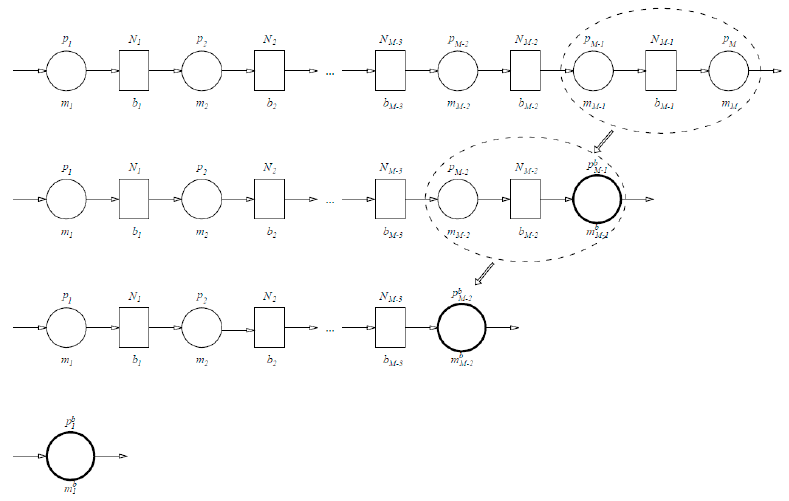
Figure 3. Backward aggregation, recreated according to [8].